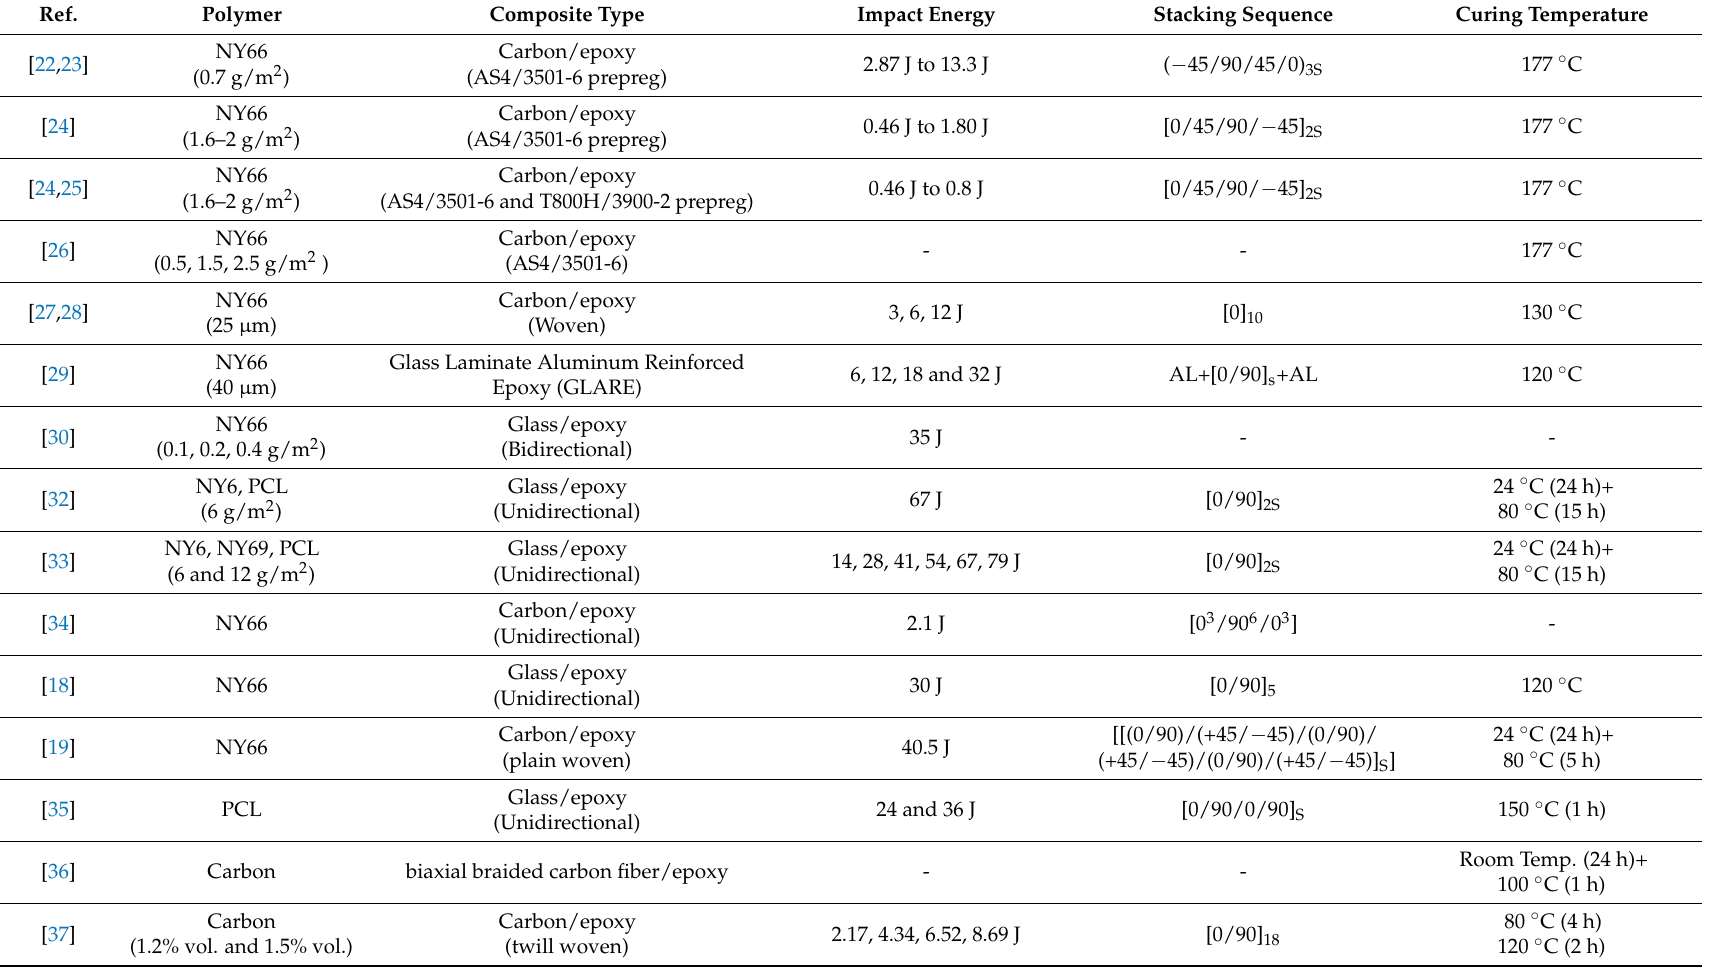
Table 1. Published paper regarding the influence of nanofibers on impact response of composite